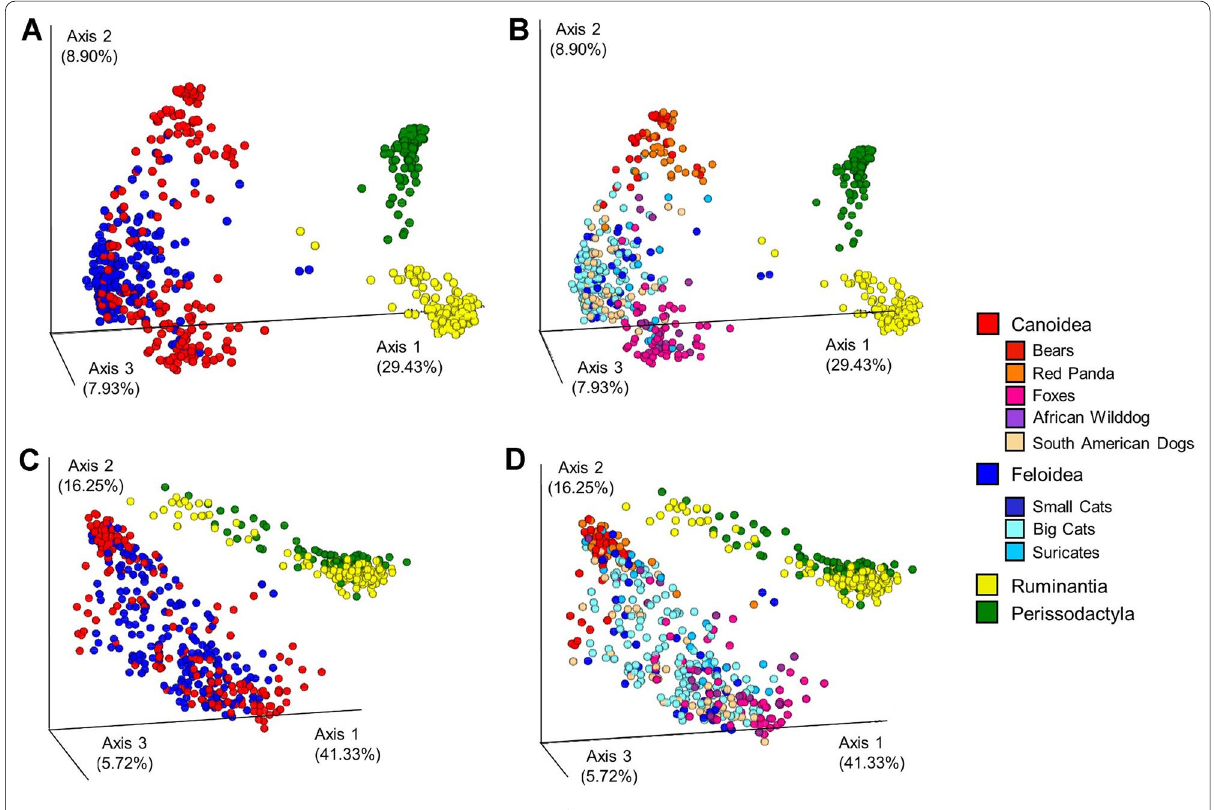
Fig. 3 Principal Coordinates Analysis on the differences between carnivores and herbivores based on an unweighted and weighted UniFrac distance matrix. Differences in samples are shown based on the four analyzed groups ( A , C ) and on a more detailed division of carnivore groups ( B , D ) as shown in the figure legend. The proportion of data explained by this measurement is shown in brackets for each